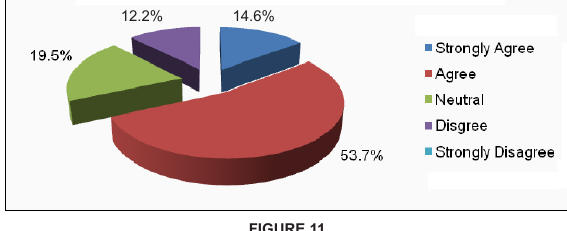
FIGURE 11 Security perception when using Internet